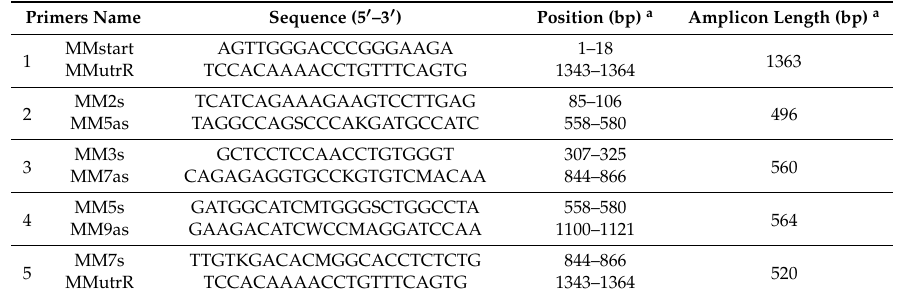
Table 7. Specific primers applied for the amplification of human PAG-L